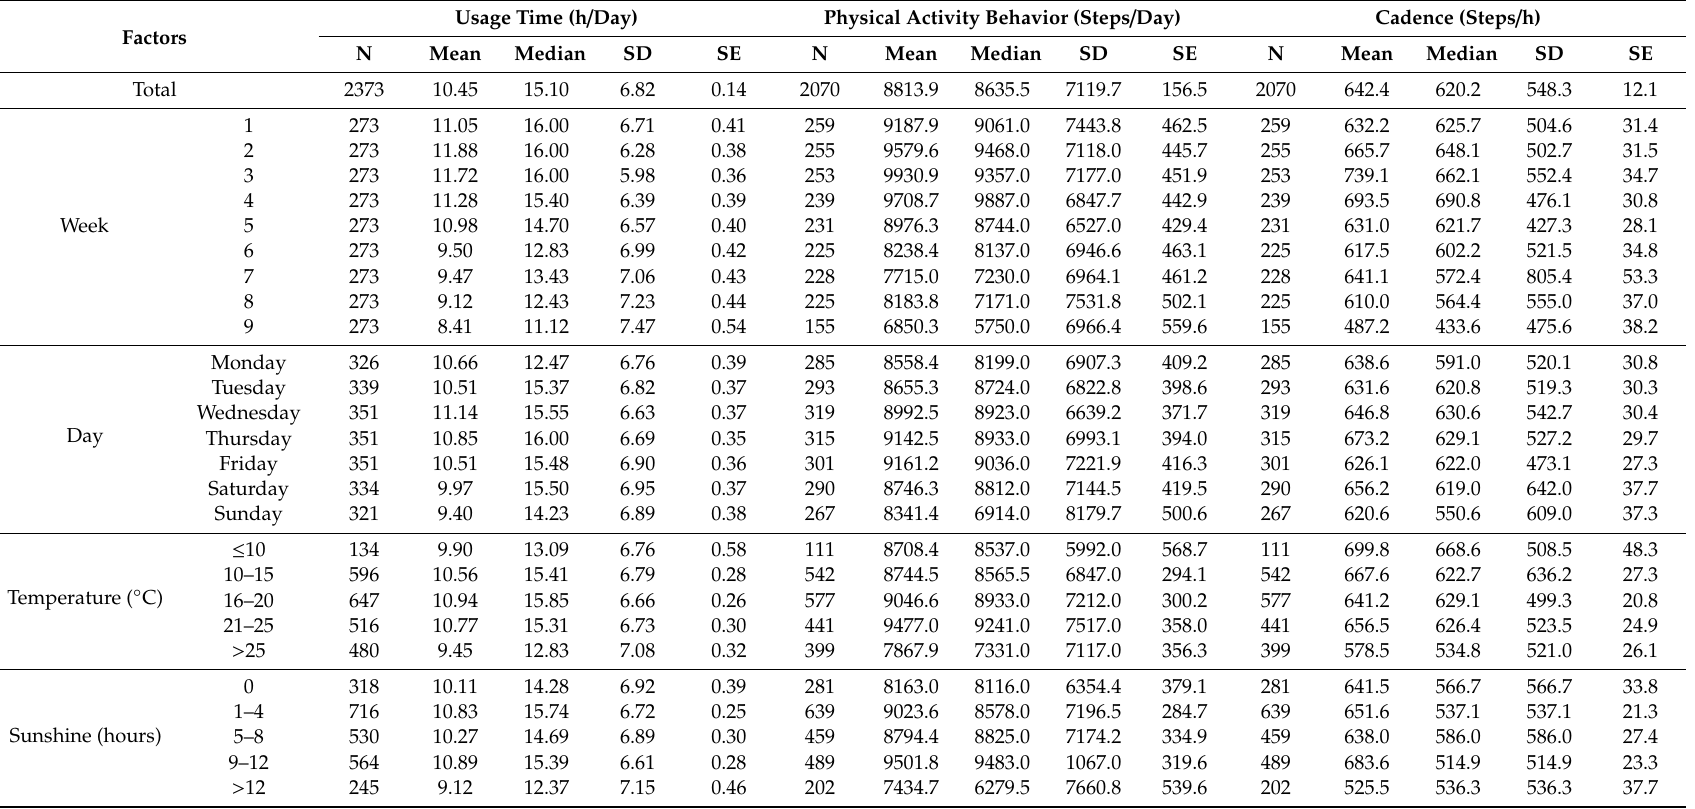
Table 1. Descriptive statistics for the dependent variables. (SD = standard deviation; SE = standard